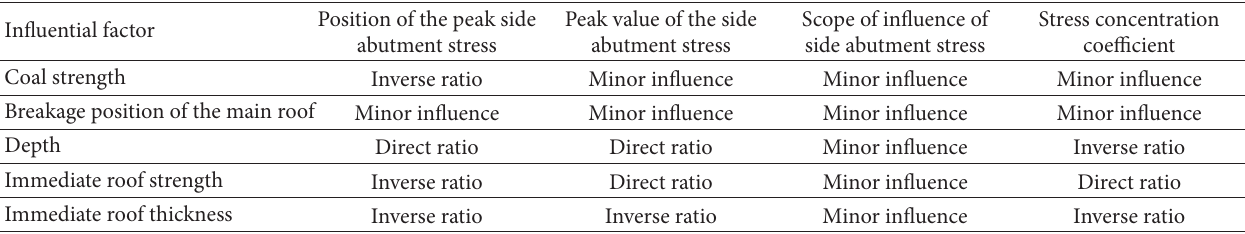
Table 5: Factors affecting the distribution of the side abutment stress.